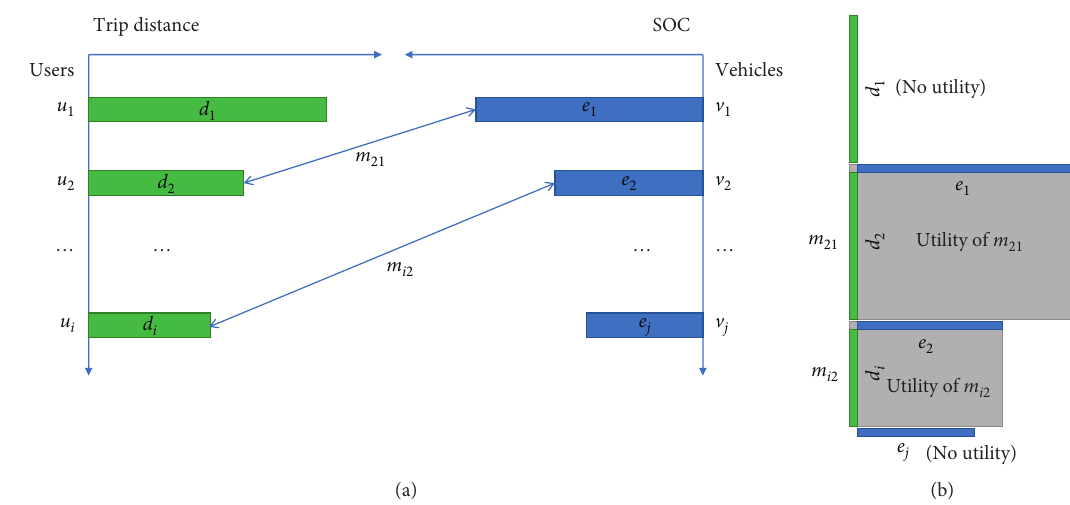
Figure 5: Events in short-term reservation mode.